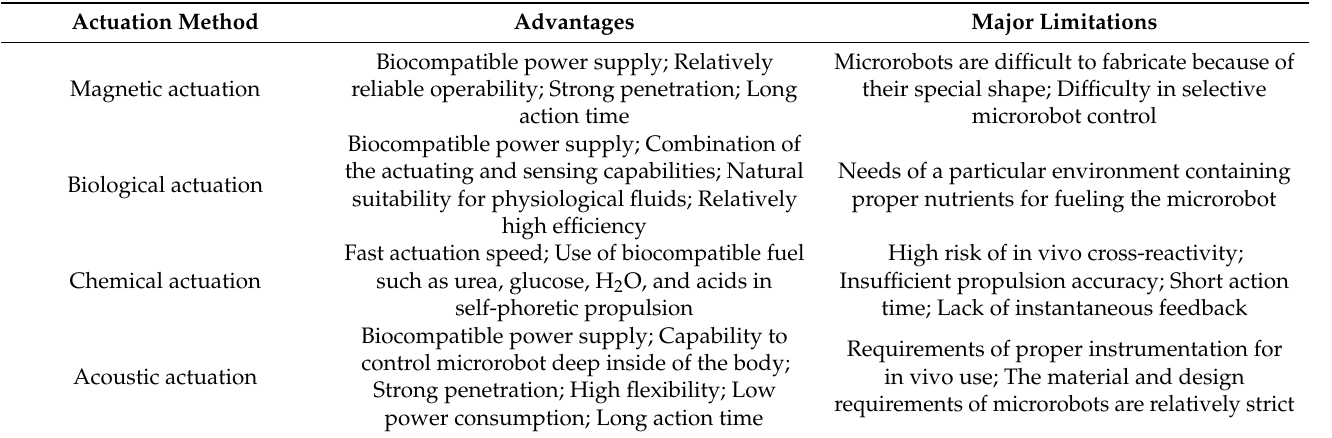
Table 1. Comparison of different actuation methods.